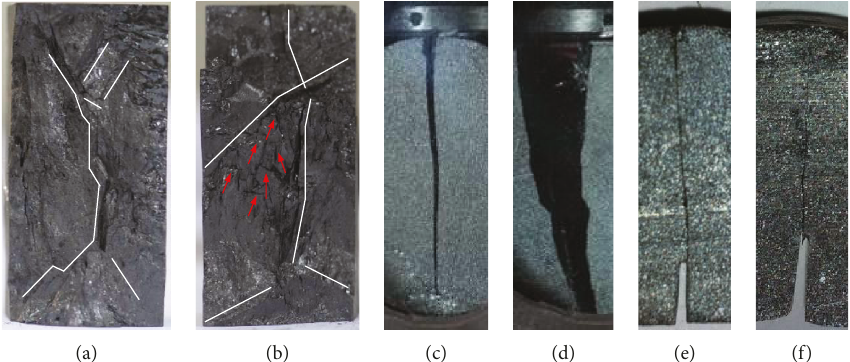
Figure 6: Failure patterns of gas-containing coal changing with gas pressures (a) UC test with no gas, (b) UC test with 1.5MPa gas pressure, (c) BD test with no gas, (d) BD test with 1.5MPa gas pressure, (e) NSCB test with no gas, and (f) NSCB test with 1.5 MPa gas